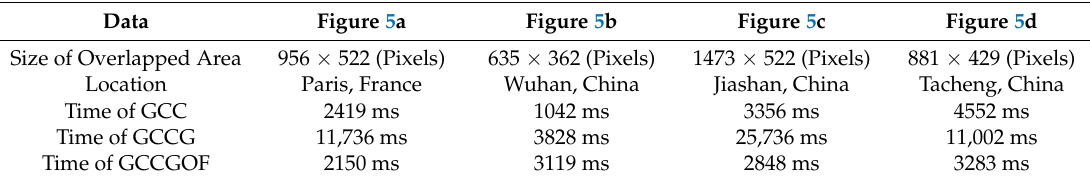
Table 2. Time efficiency comparison of three test methods